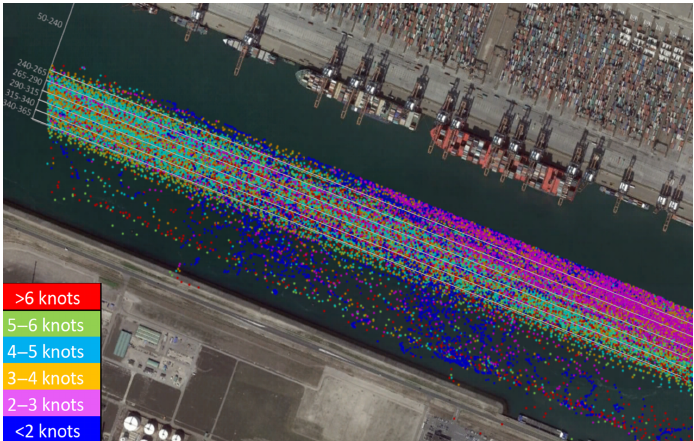
Figure 6. Passing speed AIS data projected in the port channel, between April 2018 and March 2019.